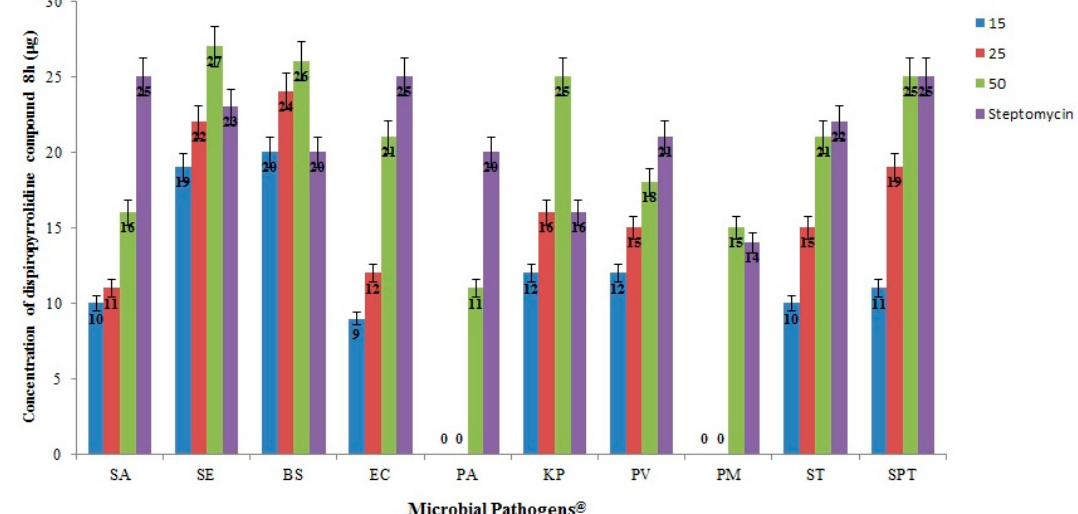
Figure 4. Antibacterial activity of dispiropyrrolidine compound 8h against Gram-positive and negative bacterial pathogens. @ SA— Staphylococcus aureus MTCC 96, SE— Staphylococcus epidermidis MTCC 3615. BS— Bacillus subtilis MTCC 441, EC— Escherichia coli ATCC 25922, PS— Pseudomonas aeruginosa ATCC 27584, KP— Klebsiella pneumoniae MTCC 109. PV— Proteus vulgaris ATCC 8427, PM— Proteus mirabilis ATCC 25922, ST— Salmonella typhi ATCC 25922, SPT— Salmonella paratyphi MTCC 735.